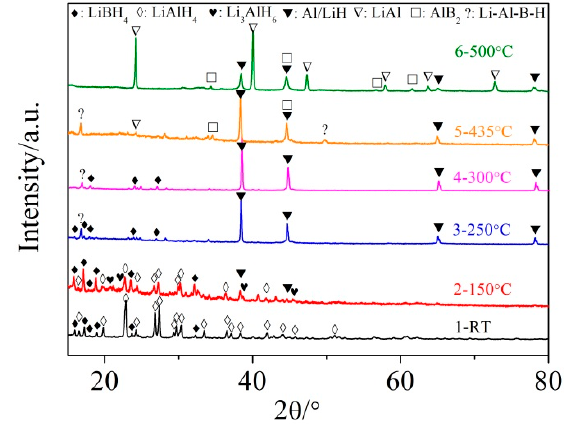
Figure 4. XRD patterns of the LiBH 4 /LiAlH 4 composite obtained at different temperatures (room temperature, 150, 250, 300, 435 and 500 °C).